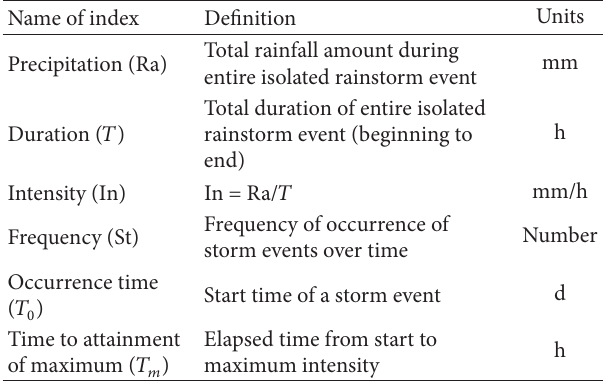
Table 1: Definition of indices of rainstorm